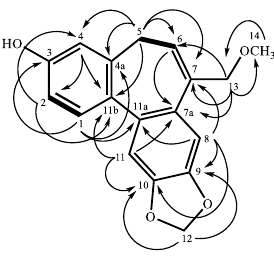
Figure 2. COSY ( Figure 2. COSY ( ▬ ) and HMBC ( → ) correlations of 1 . ) and HMBC ( → ) correlations of 1 Figure 2. COSY ( ▬ ) and HMBC ( → ) correlations of 1 .